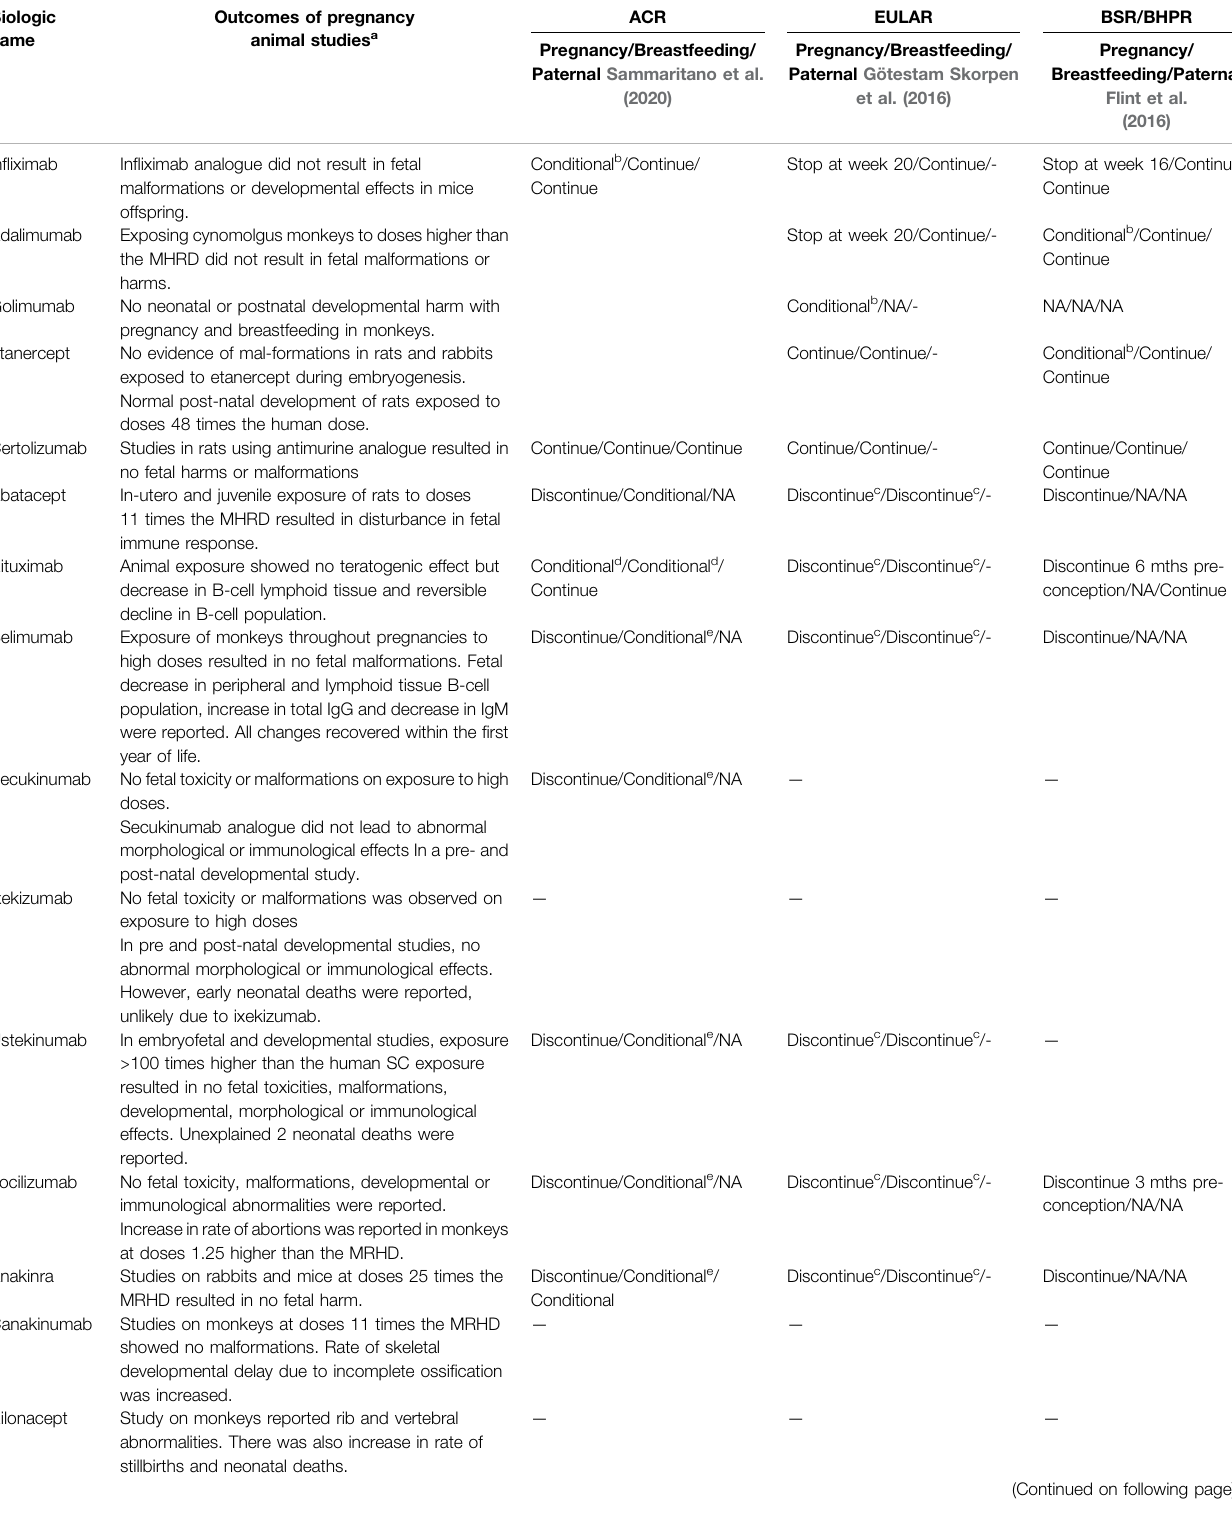
TABLE 3 | Guidelines for continuation of biological drugs in pregnancy, lactation and male